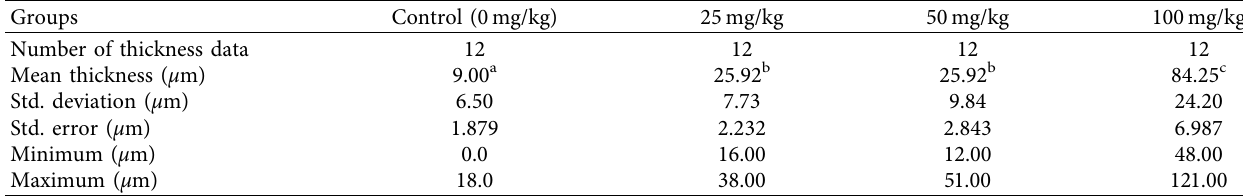
Figure 4: Bar chart showing mean values of predentin thickness in the teeth of Wistar rats after 60 days of CaO-NP administration at different dosages (25, 50, and 100mg/kg) and without any nanoparticle administration (control group). Horizontal lines connecting two bars indicate statistical significance ( P < 0 . 05). Table 1: Mean values of predentin thickness in the teeth of Wistar rats after 60 days of CaO-NP administration at different dosages (25, 50, and 100mg/kg) and without any nanoparticle administration (control